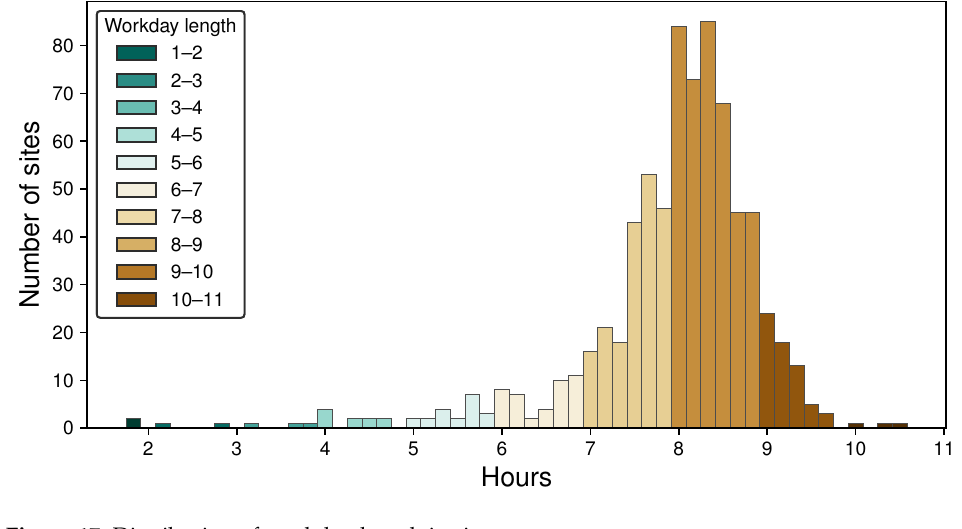
Figure 17. Distribution of workday length in sites.